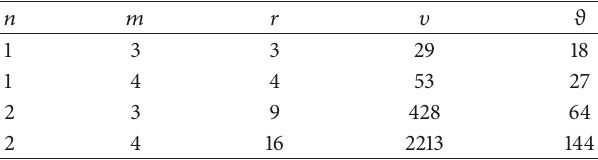
Table 1: The comparison results of the numbers of LMIs satisfied between Theorem 3 in [30] and Theorem 9 in this